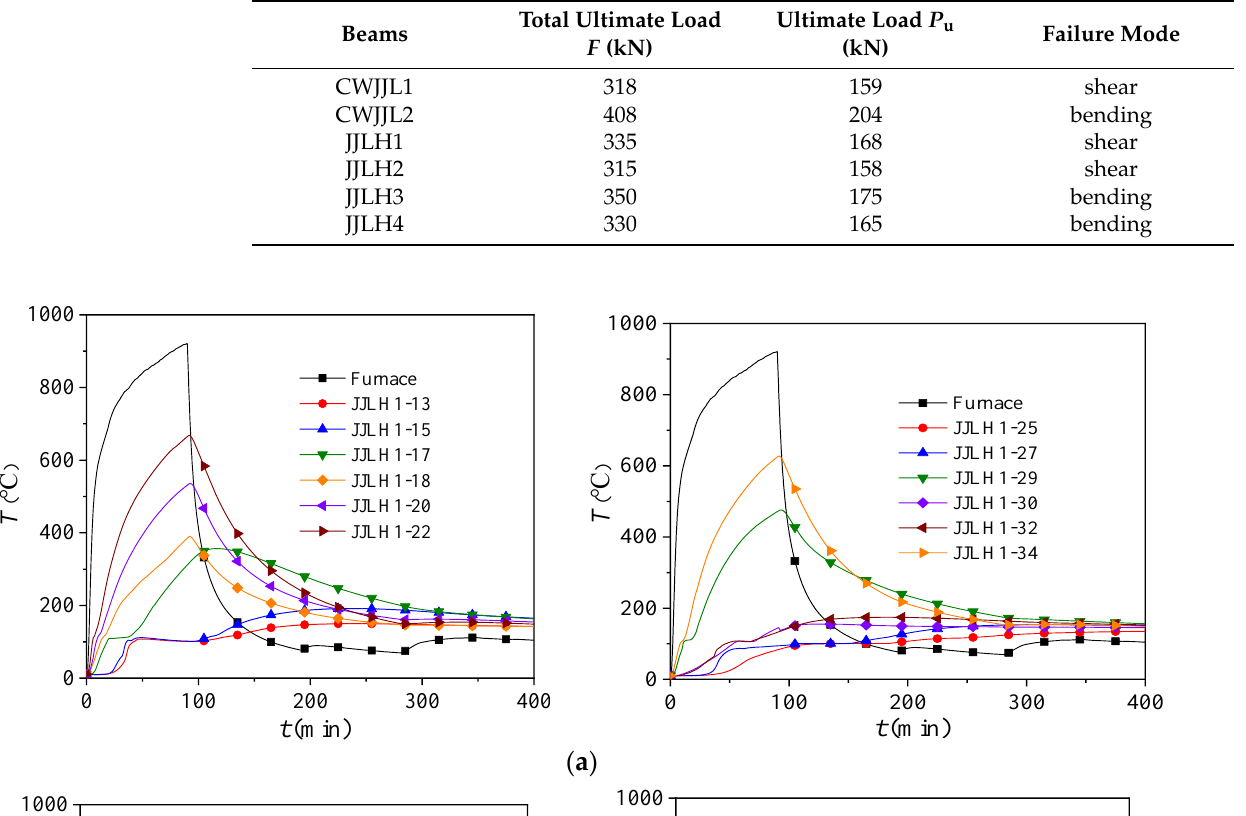
Figure 7. Measured temperature curves in the furnace. Table 2. Ultimate load of beams.